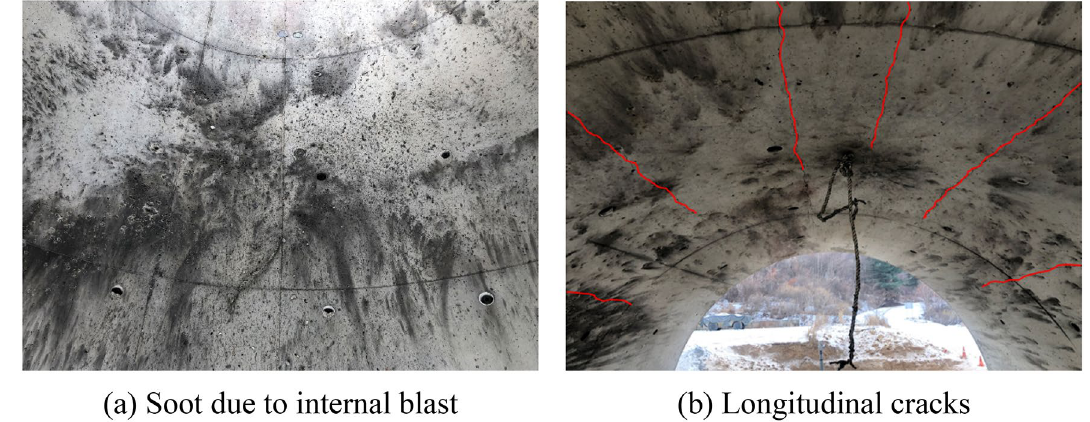
Figure 13. Crack patterns of specimens. ( a ) Soot due to internal blast. ( b ) Longitudinal